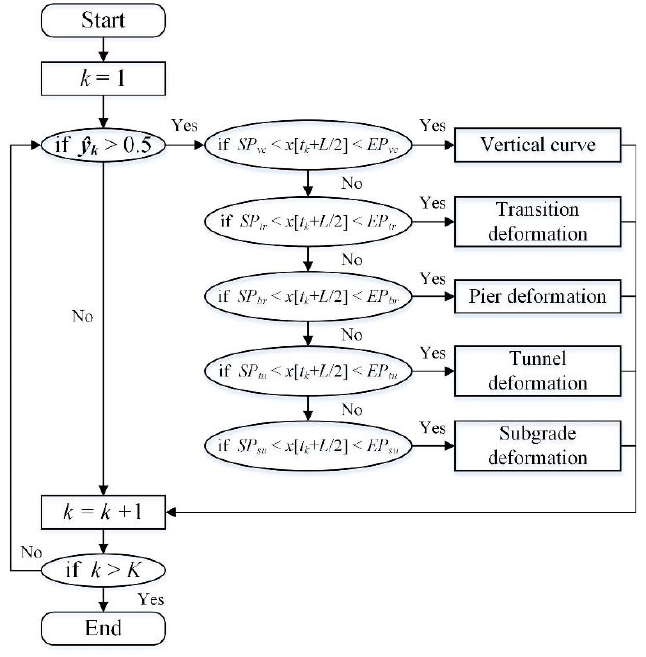
Figure 7. The flow chart of position-matching algorithm.